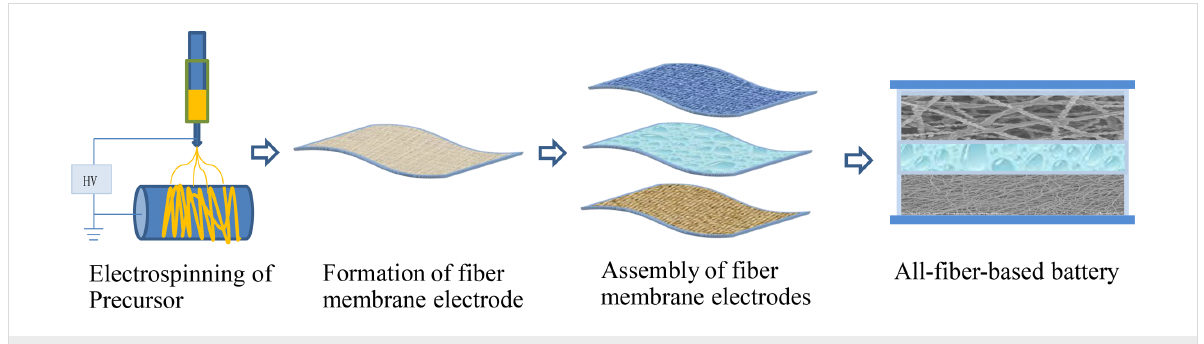
Figure 1: Fabrication process of all-fiber-based gel-state batteries.